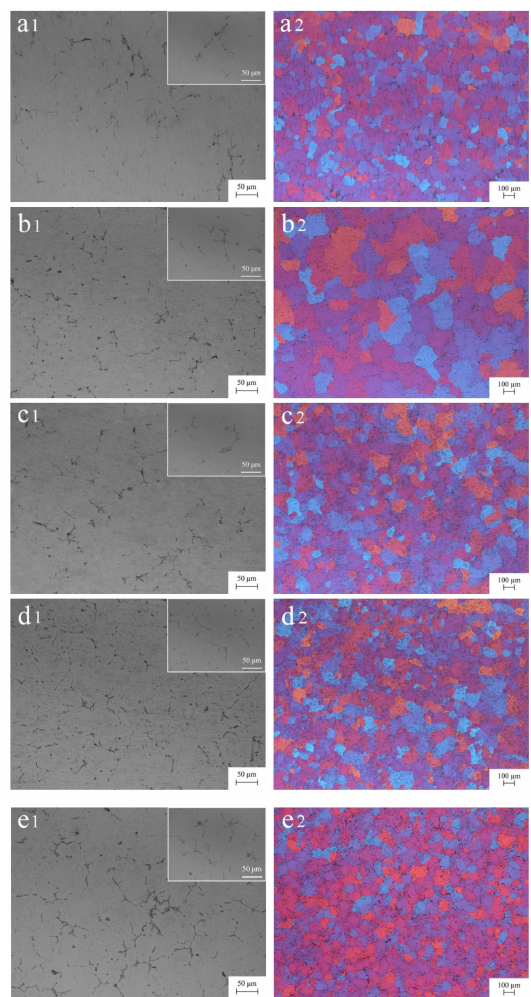
Figure 3. Metallographic structure of homogenized 5052 aluminum alloys with embedded graphs to reflect the local characteristics on the top right of images: ( a1 , a2 ) A0 without Er; ( b1 , b2 ) A1 with 0.1% Er; ( c1 , c2 ) A2 with 0.2% Er; ( d1 , d2 ) A3 with 0.4% Er and ( e1 , e2 ) A4 with 0.8%